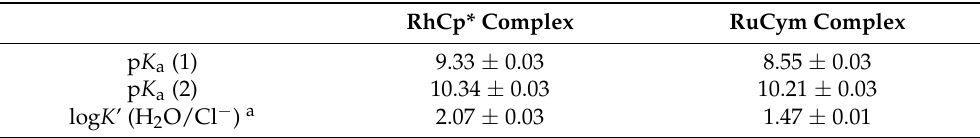
Table 3. p K a values of the RhCp* and RuCym complexes of HQNO 2 -L-Pro and the H 2 O/Cl − ex- change constants determined (at pH 7.4 for RhCp*, pH 6.0 for RuCym) by UV-vis spectrophotometric titrations. { I = 0.2 M (KNO 3 ); t = 25.0 ◦